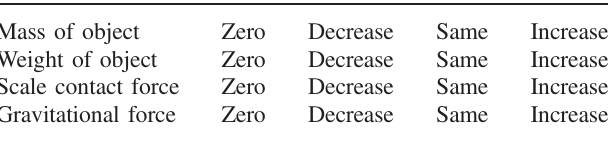
table below .) Mass of object Zero Decrease Same Increase Weight of object Zero Decrease Same Increase Scale contact force Zero Decrease Same Increase Gravitational force Zero Decrease Same Increase Draw a force diagram ([(of force(s) acting on